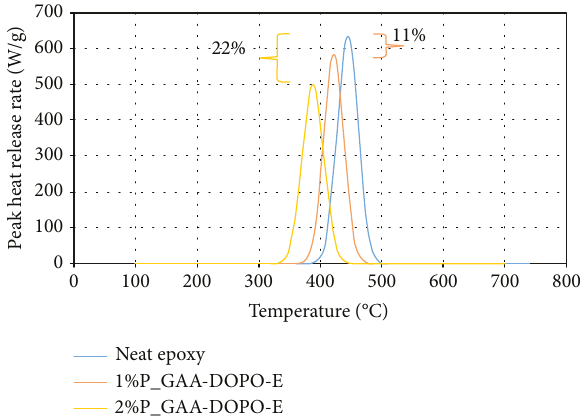
Figure 3: Peak heat release rates for blends of 3,4,5- tri(dopyloxy)benzanilide with DGEBA epoxy